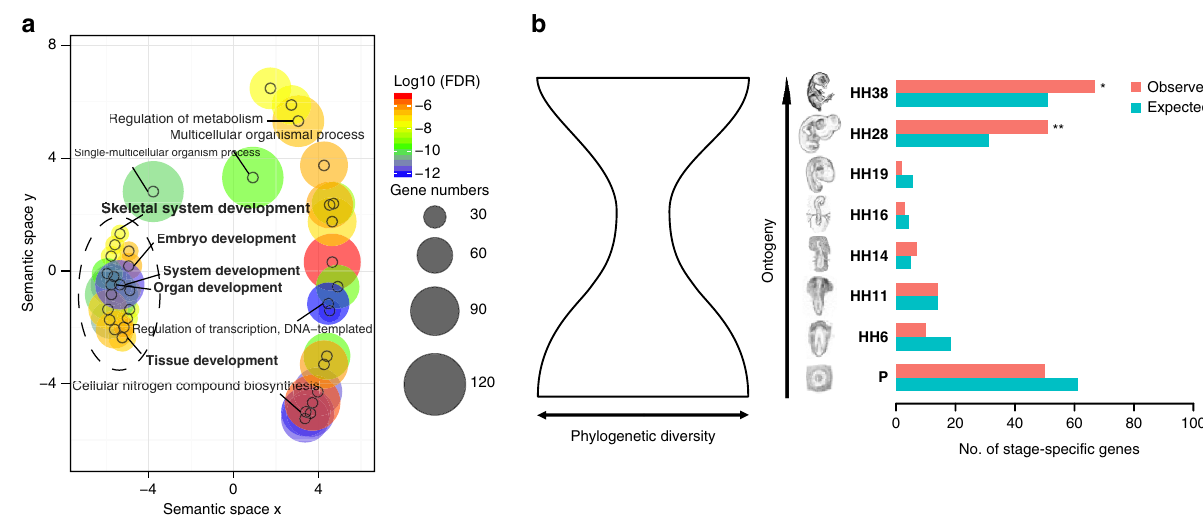
Figure 3 | Potential role of ASHCE-associated genes in avian development. ( a ) Enriched GO terms in the top 500 ASHCE-associated genes. The P -values of enrichment were calculated using a chi-squared test, and FDRs were computed to adjust for multiple testing. Since the list of enriched GOs was long, the figure was generated by the visualization tool REVIGO which clustered the GOs based on semantic similarity. The development-related GOs are highlighted with bold fonts. ( b ) Stage-specific genes within the top 500 ASHCE-associated genes and those of genomic background (all genes) are shown for each developmental stage. Note that HH28 and HH38 stages show statistically significant over-representation of stage-specific, top 500 ASHCE-associated genes relative to genomic background. ‘expected’, expected numbers of stage-specific genes among randomly picked-up 500 genes. * P o 0.05 using Fisher’s exact test; ** P o 0.01. On the left is the hourglass-like development